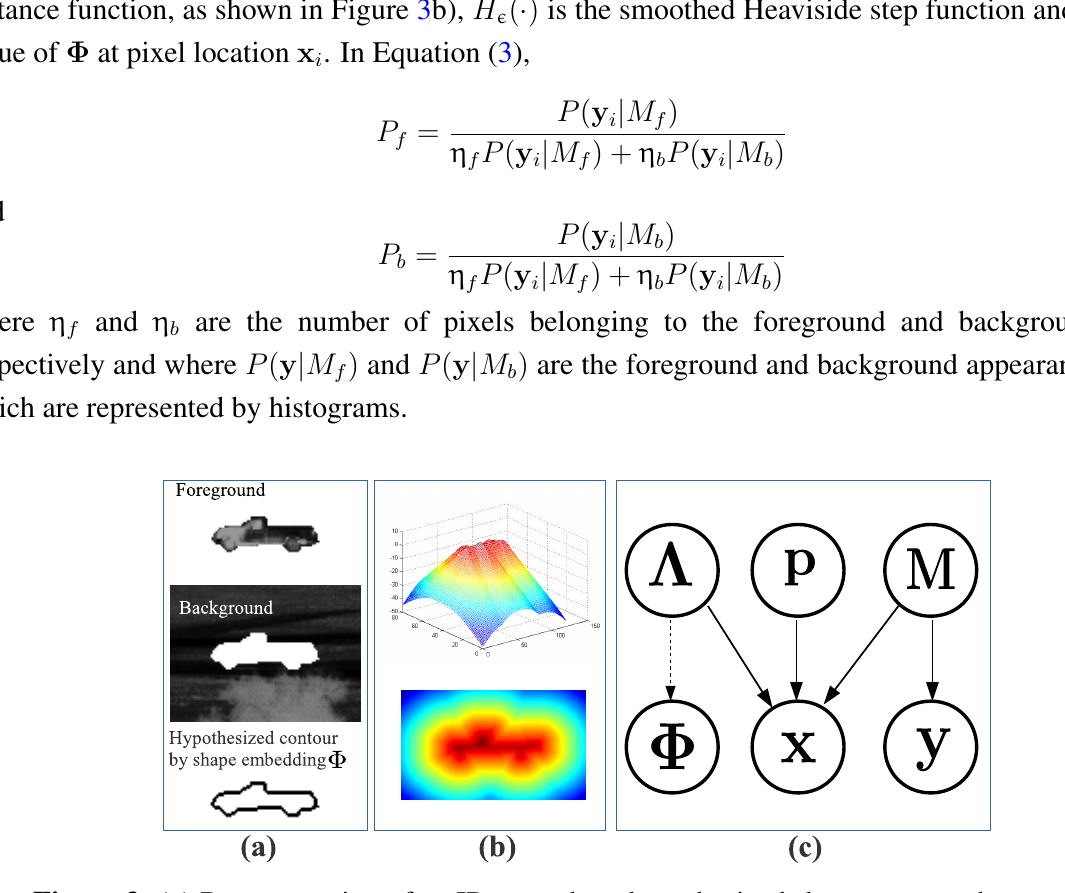
Figure 3. ( a ) Representation of an IR target by a hypothesized shape contour that separates the foreground and background regions; ( b ) shape embedding function Φ represented by the signed distance transform. Φ is generated by CVIM given the parameter vector Λ , which contains the view angles Θ and identity variable α ; ( c ) The proposed probabilistic level set framework, where p is the target centroid in image coordinates, M is the foreground/background model, x is a pixel location in image coordinates and y is a pixel intensity value. The dashed line represents the CVIM-based mapping from the latent shape space Λ to the shape embedding function Φ